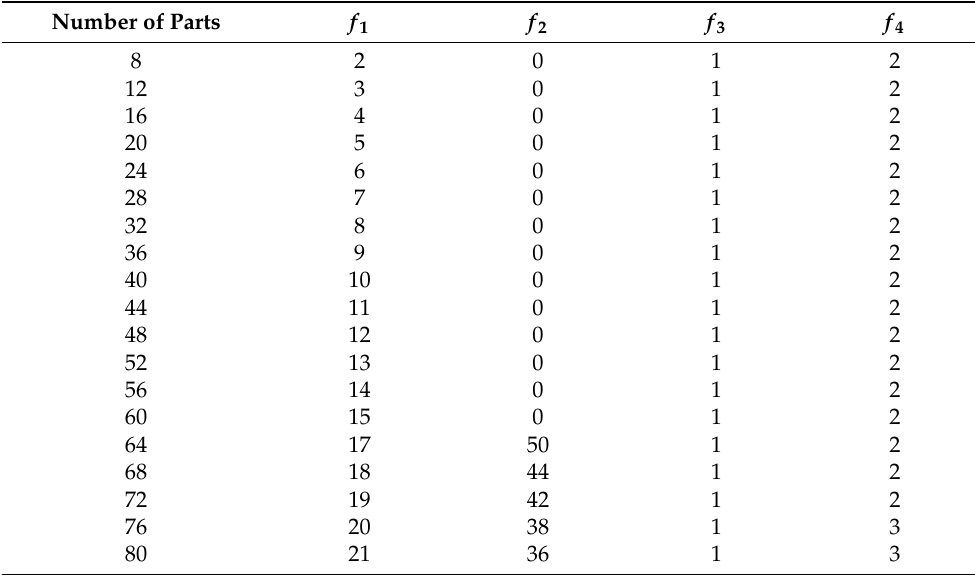
Table 4. Results of random